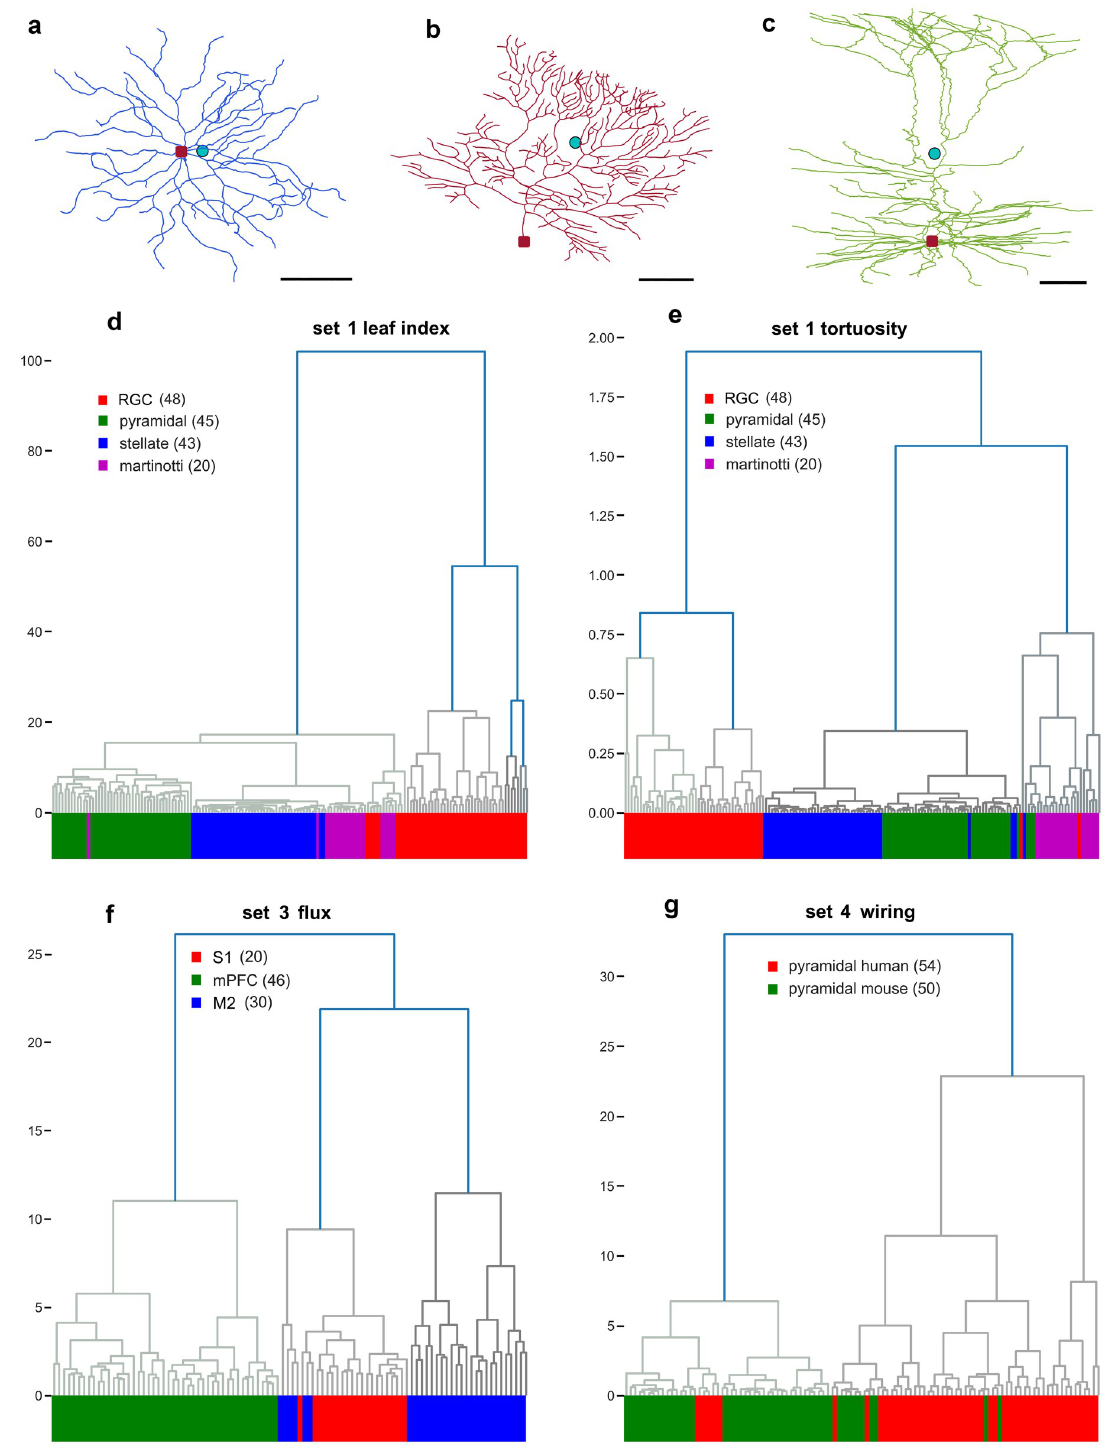
Fig 5. Hierarchical clustering trees for selected descriptors. Representative neuronal reconstructions of ( a ) interneuron ( b ) purkinje, and ( c ) cortical pyramidal cell, in blue, magenta, and green colors respectively. Representative dendrograms based on descriptors for ( d ) Leaf index and ( e ) tortuosity for Dataset 1, ( f ) Flux for Dataset 3, and ( g ) wiring for Dataset 4. For the reconstructions ( a,b,c ), the red dot represents the soma and the turquoise dot is the barycenter of all nodes. Scale bar in a = 10 μ M, b = 25 μ M, and c = 50 μ M.